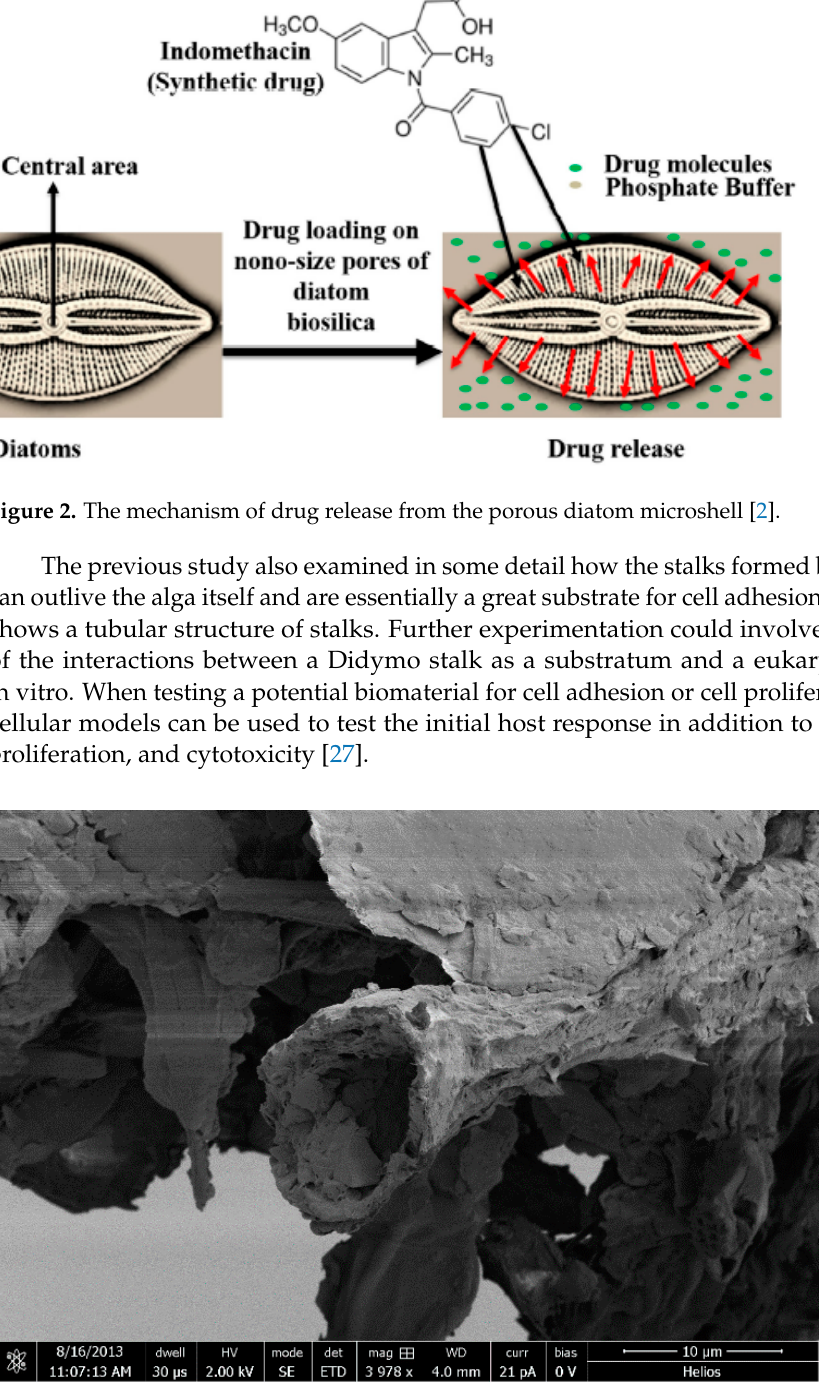
Figure 3. SEM image of the broken stalk of D. geminata clearly shows its tubular structure.